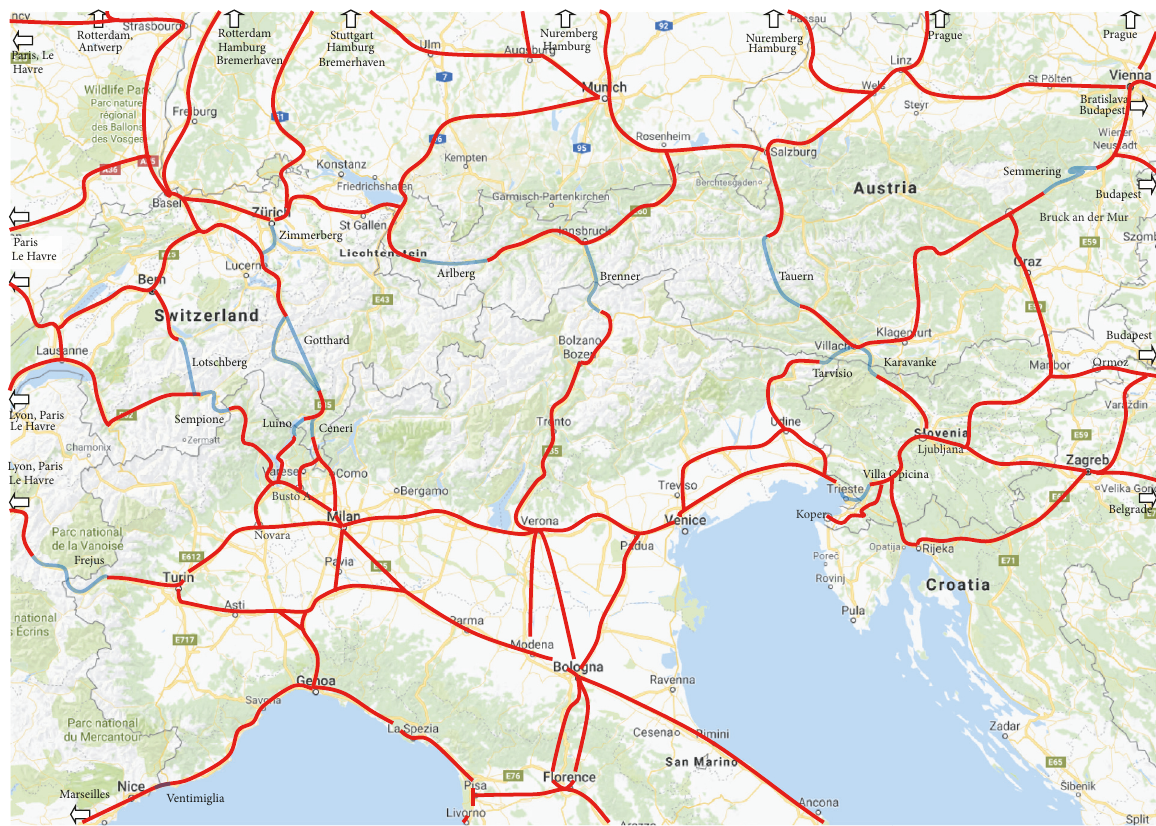
Figure 2: The main rail lines (represented in red) across Alpine passes (shown in blue).